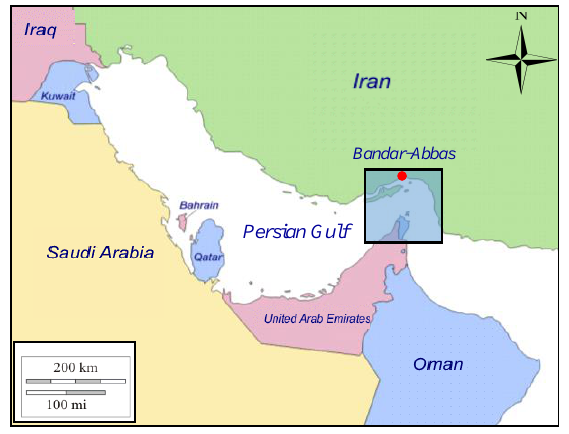
Figure 1. Case study: the Striat of Hormuz